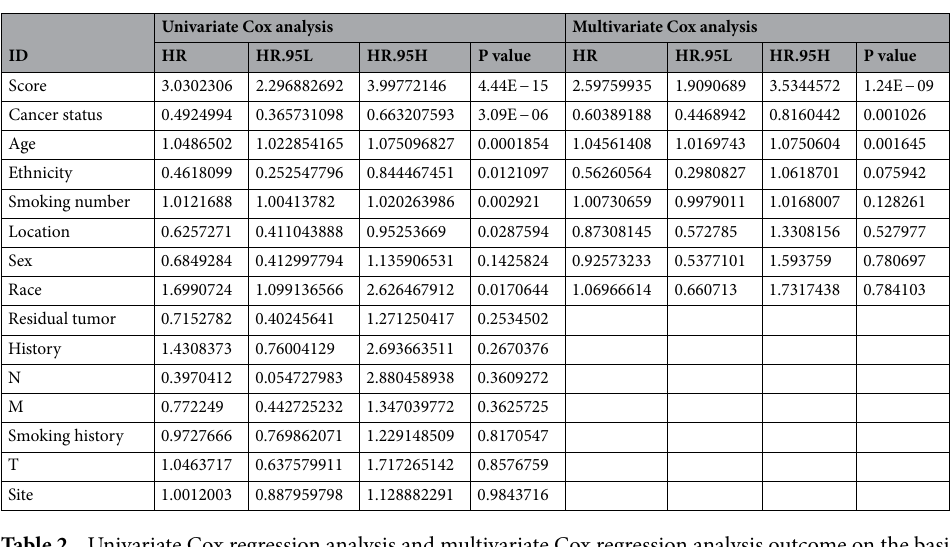
Table 2. Univariate Cox regression analysis and multivariate Cox regression analysis outcome on the basis of risk score and other clinical factors.